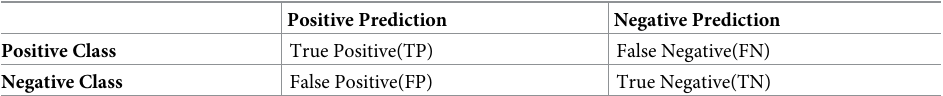
Table 2. Binary confusion